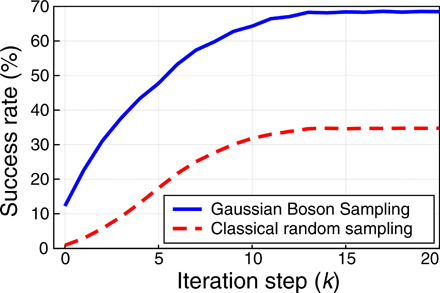
GBS versus classical success rate.Success rate in finding the maximum weighted clique after greedy shrinking and k expansion steps with local search. Samples are generated from either GBS or a purely classical approach. GBS maintains a significantly higher success rate over all iteration steps.